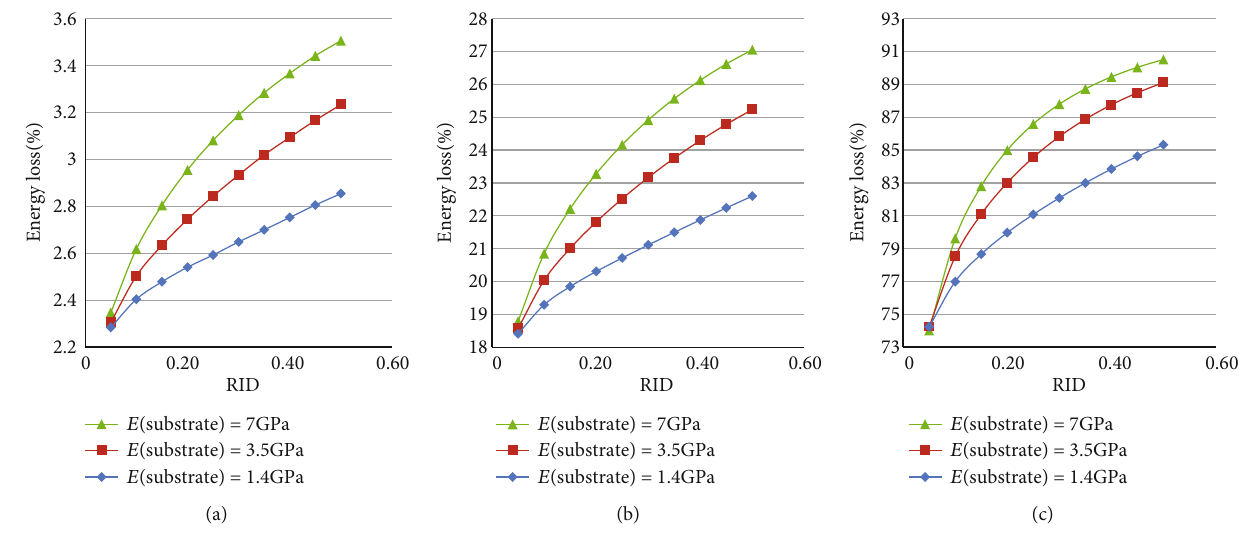
Figure 13: Energy loss of varying substrates when g